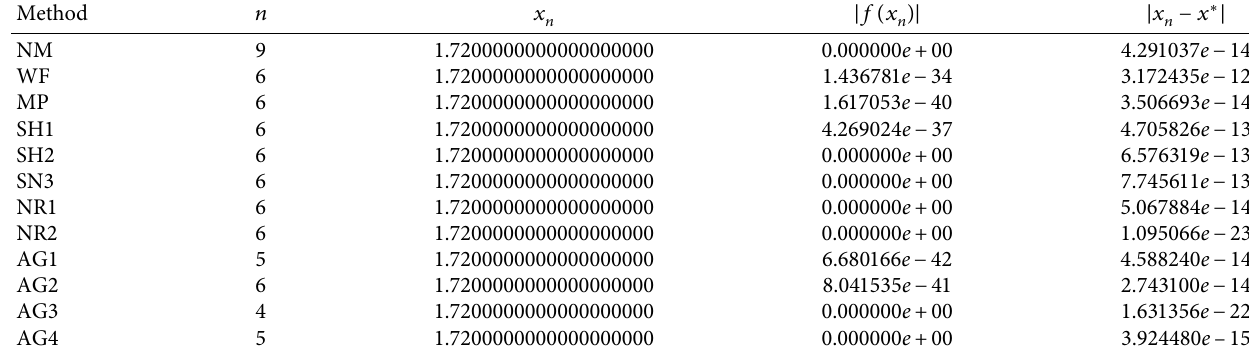
Table 2: Numerical results for Van der Waals equation of state.